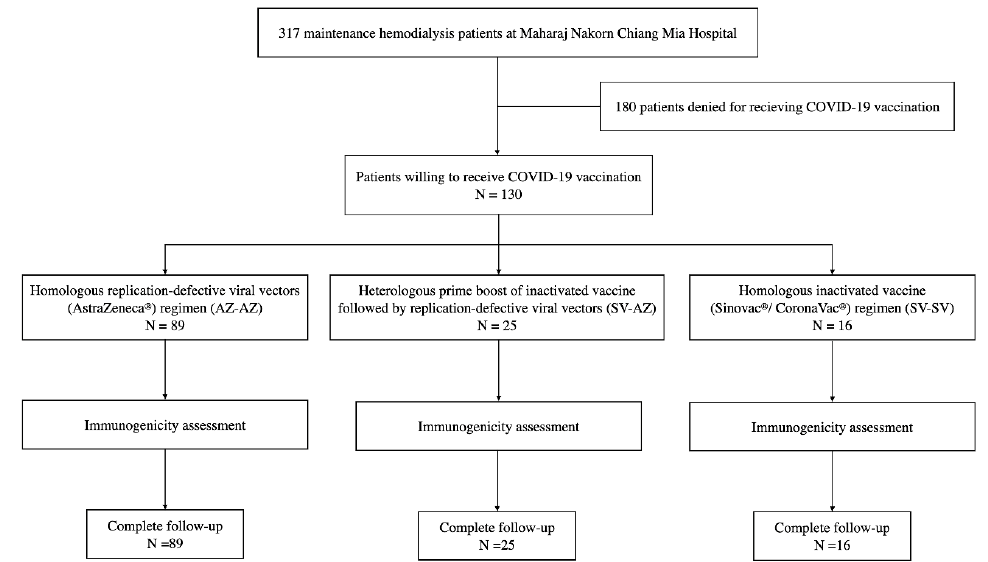
Figure 1. Study design and flow diagram. AZ-AZ, homologous AZD1222 regimen; SV-AZ, heterologous Sinovac-AZD1222 regimen; SV-SV, homologous Sinovac regimen.